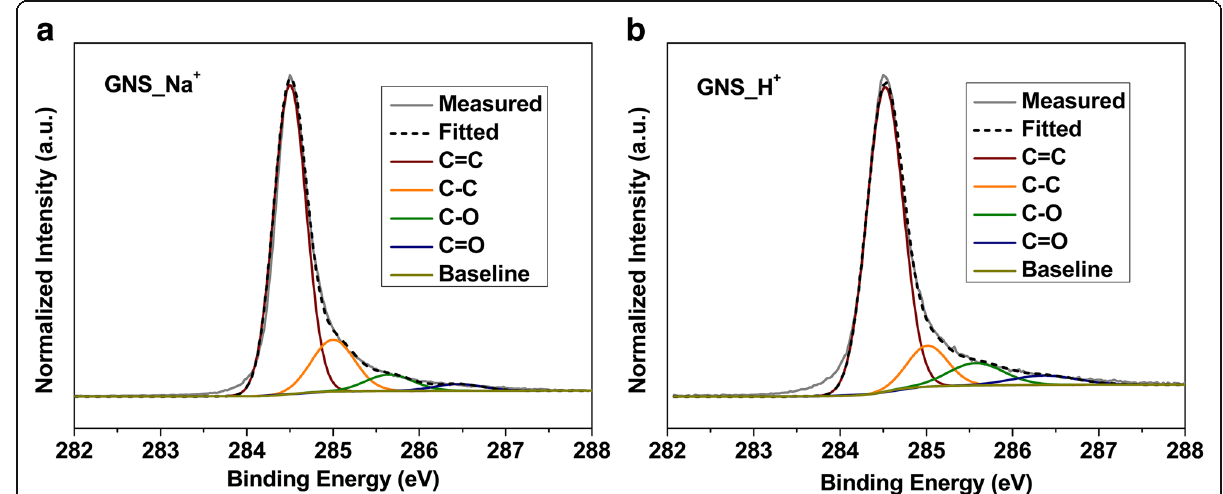
Fig. 3 High-resolution C 1s XPS spectra of a GNS_Na + and b GNS_H